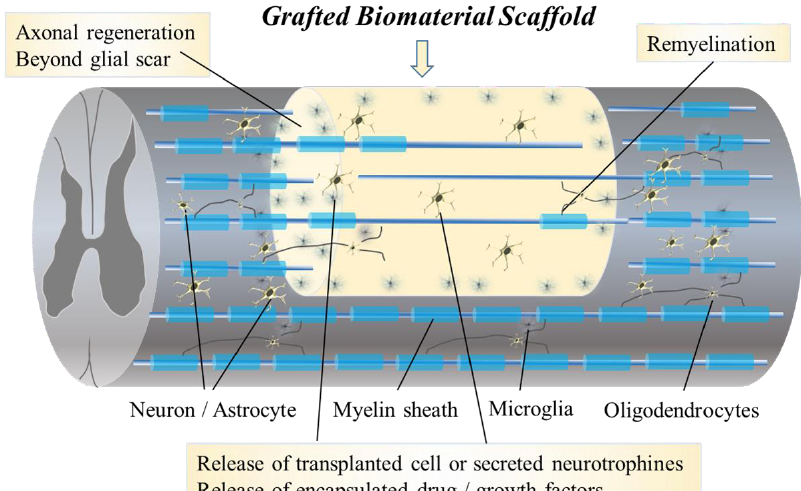
Figure 2. The diagram shows the pathophysiological change following a biomaterial scaffold graft. Certain biomaterials contain stem cells, drugs, neurotrophines or growth factors, etc. Grafted biomaterials support axonal regeneration beyond the glial scar as a scaffold. Grafted biomaterial scaffolds release the transplanted cells or secreted neurotrophines, and, in addition, they release the encapsulated drugs or growth factors, etc. They support the formation of new synaptic circuits and connectivity between host neurons and axons, and, in addition, they improve morphological and behavioral outcomes after experimental SCI. Oligodendrocytes derived from grafted stem cells remyelinate damaged host axons. Regenerated and remyelinated axons pass through the injured lesion and connect to other host neurons supported by interneurons and glial cells derived from grafted stem cells.